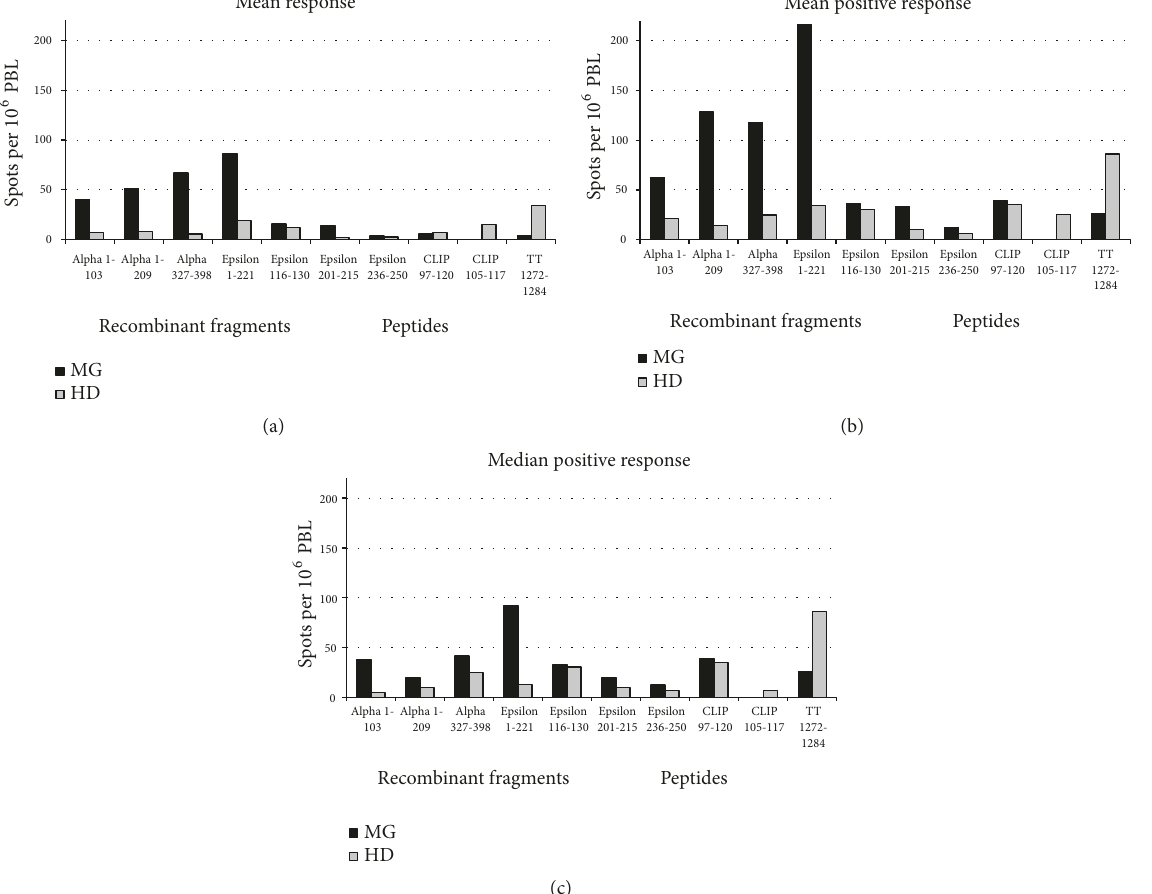
PBL minus the corresponding numbers of events per 10 6 PBL without antigen. Negative results (spot number without antigen exceeding spot number with antigen) were defined zero. MG, myasthenia gravis patients; HD, healthy